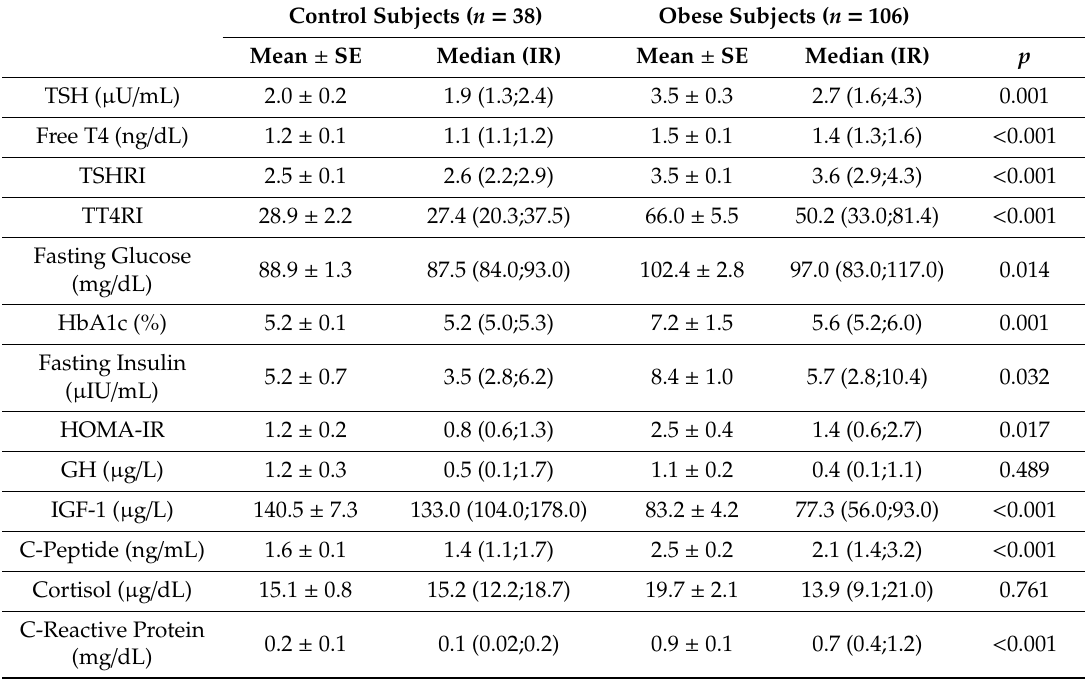
Table 2. Biochemical and Hormonal data in control subjects and obese patients (Mean ± SE; median, interquartile ranges).